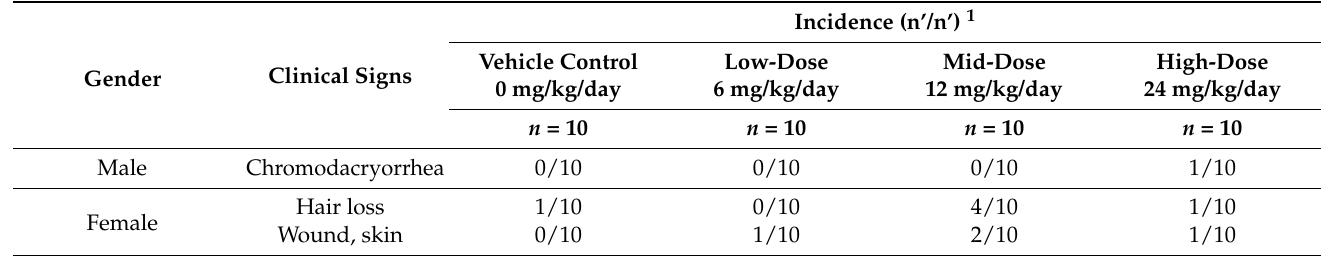
Table 3. Clinical observations of rats receiving astaxanthin over a 13-week period.